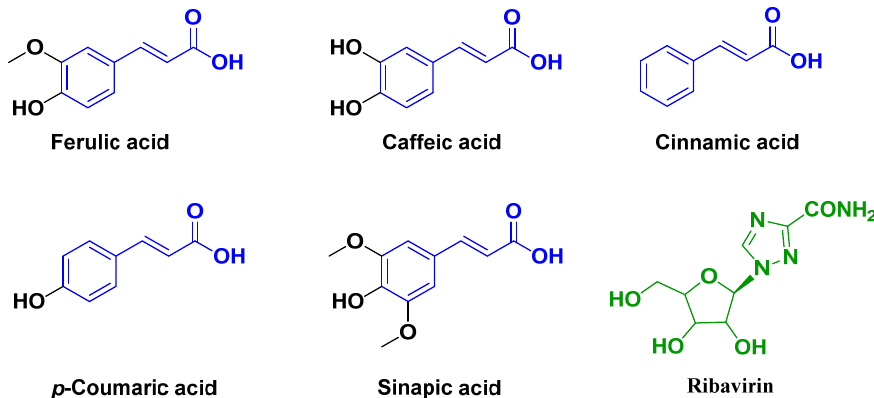
Figure 1. The structures of ferulic acid and its analogues, as well as the commercial antiviral agent